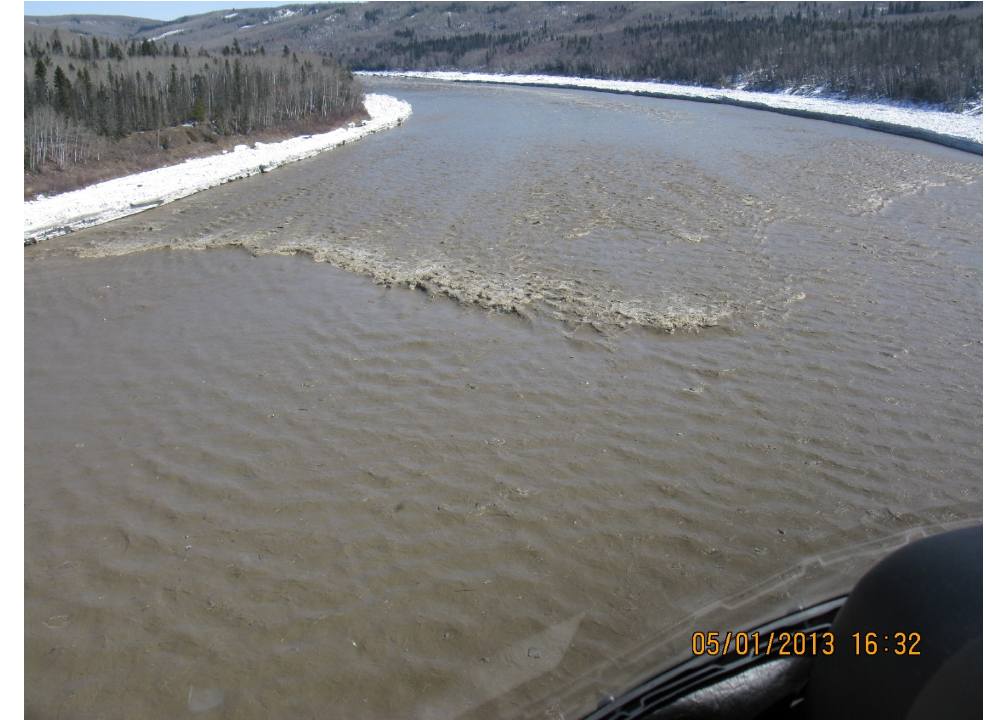
Figure 5. Appearance of water surface after an ice run near Mountain Rapids, ~12 km upstream of Grant MacEwan bridge at Fort McMurray, Alberta, 1 May 2013. As the jave progresses downstream, concentrations of suspended sediment in upstream reaches gradually decrease but remain high relative to typical open-water conditions. Photo by S. Beltaos.